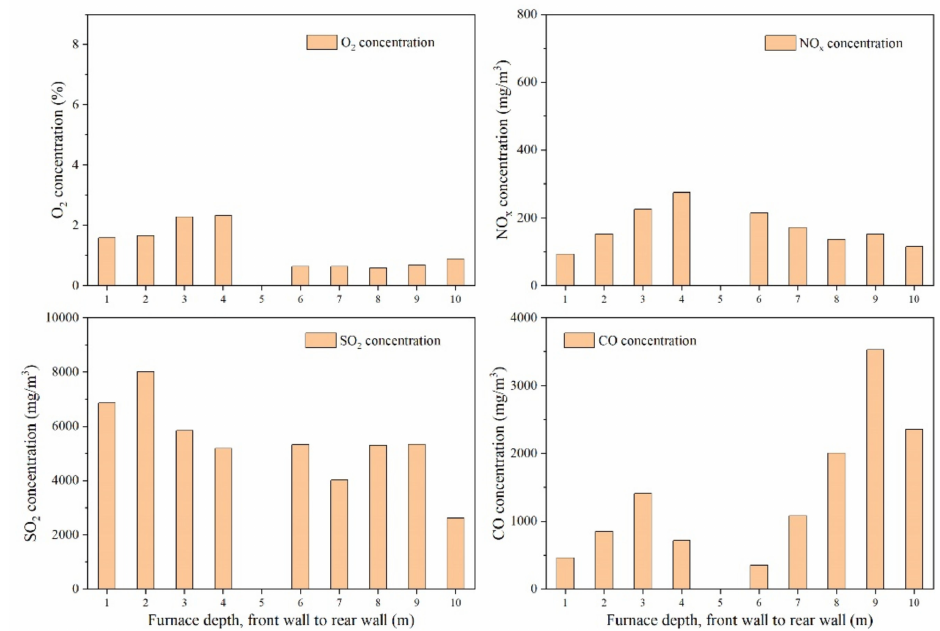
Figure 6. Horizontal distributions of flue gas composition at the dilute phase zone corresponding to the #A SNCR